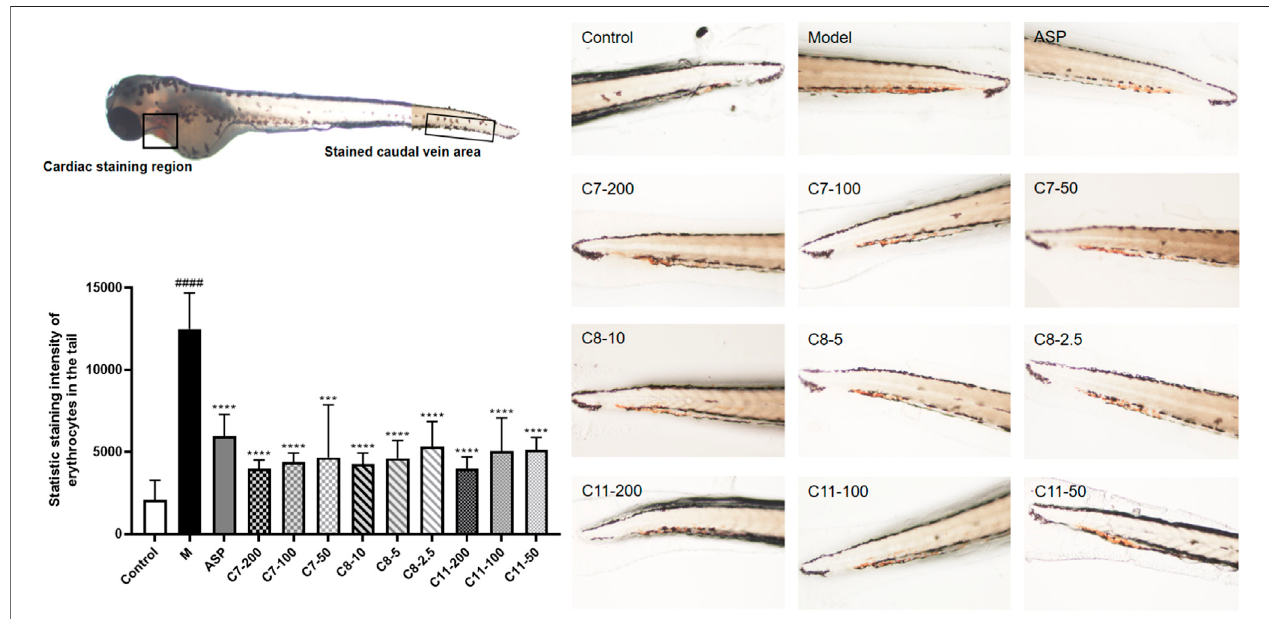
FIGURE 4 | Antithrombotic activity of C7, 8, and 11 in zebra fi sh ( n (cid:1) 10, mean ± standard deviation). In vivo visualization of the erythrocytes of zebra fi sh tails, and statistic staining intensity ofthe erythrocytes in zebra fi sh tails of all the groups. *** p < 0.001 compared to the model (M) group. **** p < 0.0001 compared to the M